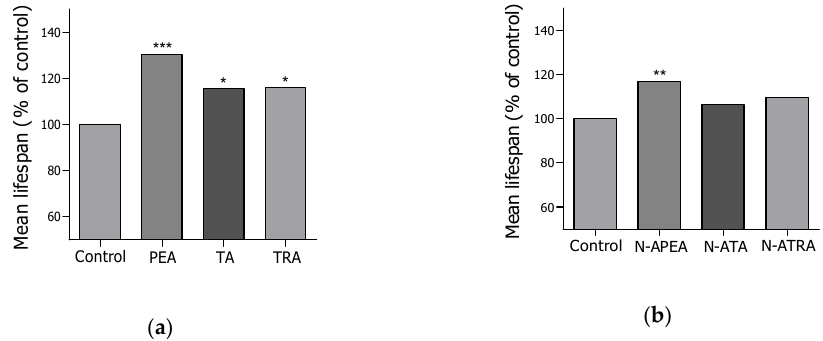
Figure 2. Lifespan screening of PEA, TA, and TRA ( a ), as well as their N -acetyl derivatives, N-APEA, N-ATA, and N-ATRA ( b ), in wild-type N2 C. elegans . Each screening assay was performed once, and each group in the experiment consisted of 50 worms.